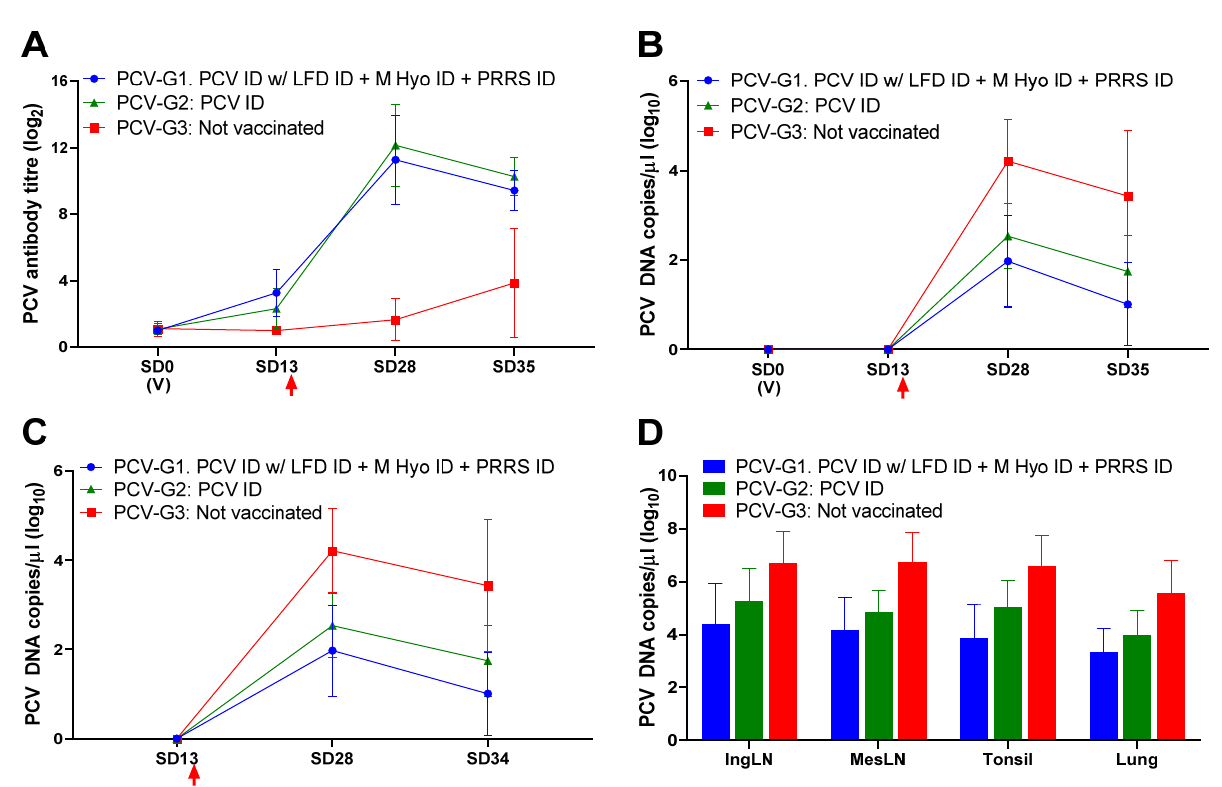
Figure 1. PCV challenge study results. ( A )—mean antibody response in PCV ELISA; ( B )—PCV viraemia (mean DNA load in serum); ( C )—mean PCV DNA load in rectal swab samples; ( D )—mean PCV DNA load in tissue homogenates. (V) Indicates time of vaccination. Arrow indicates challenge. Error bars show standard deviation.